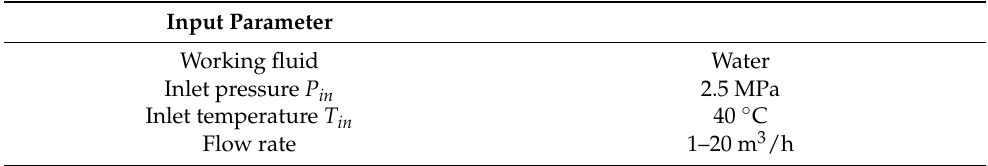
Table 3. Input operating parameters of the simulation.